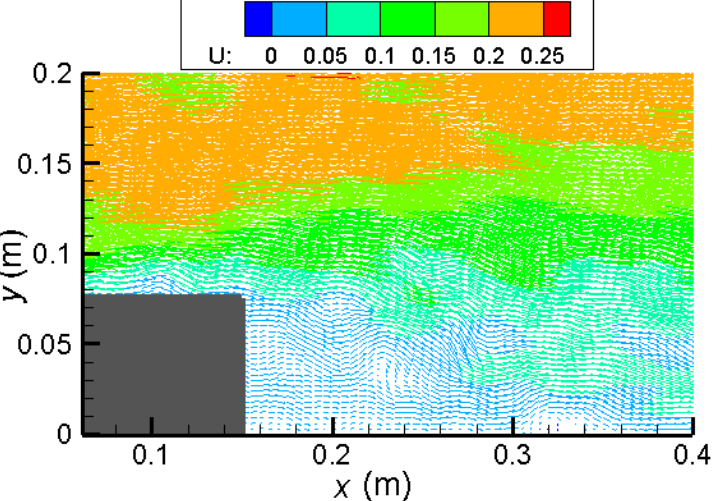
Figure 24. Back vortex field of the pore structure when the porosity is 0.475. U: Longitudinal velocity (m/s).